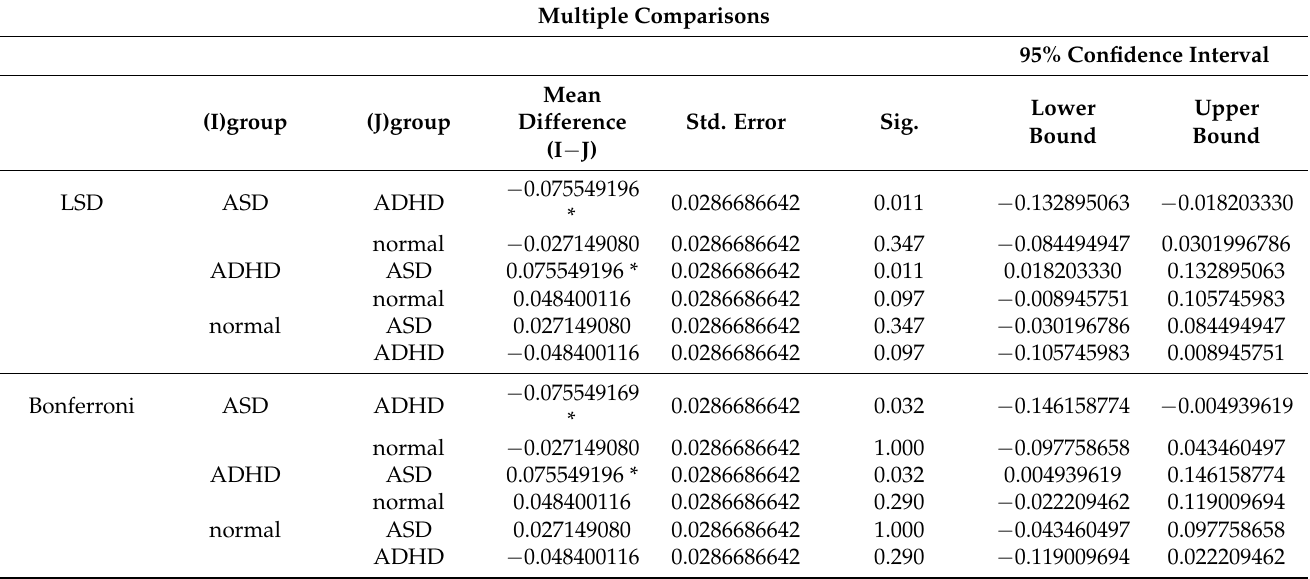
Table 6. Post hoc tests for each dependent variable. Pairwise comparisons for all combinations of the group factor (independent